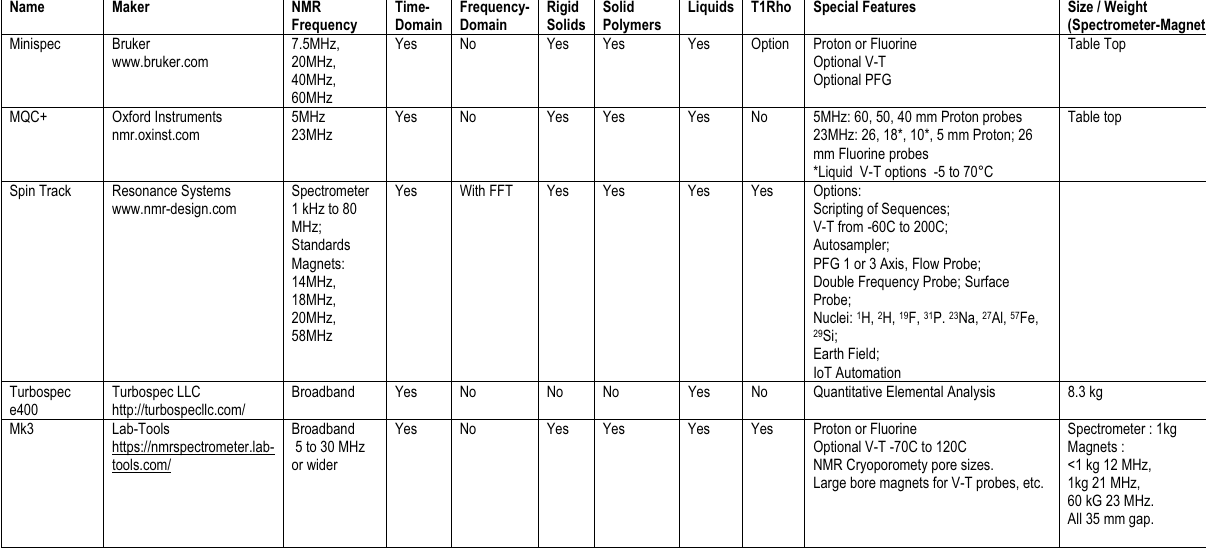
Spectrometer : 1kg Magnets: